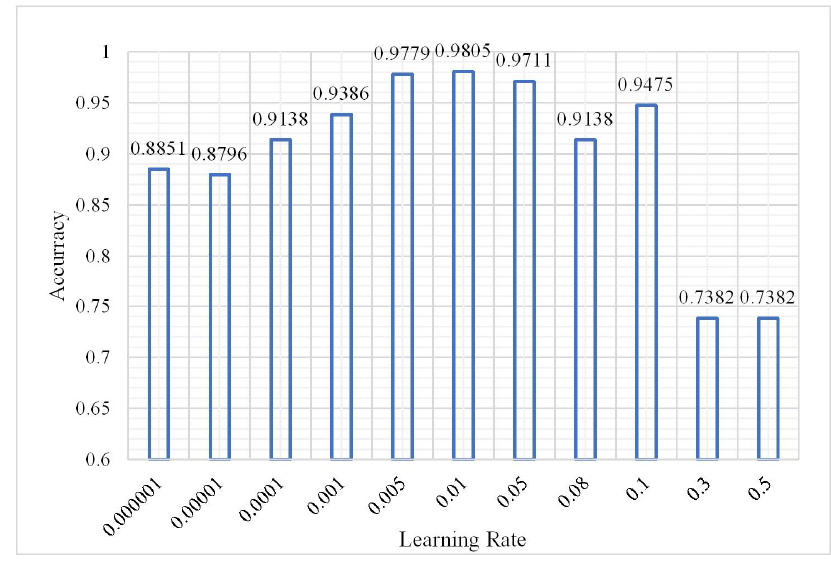
Figure 12. Change in overall accuracy.